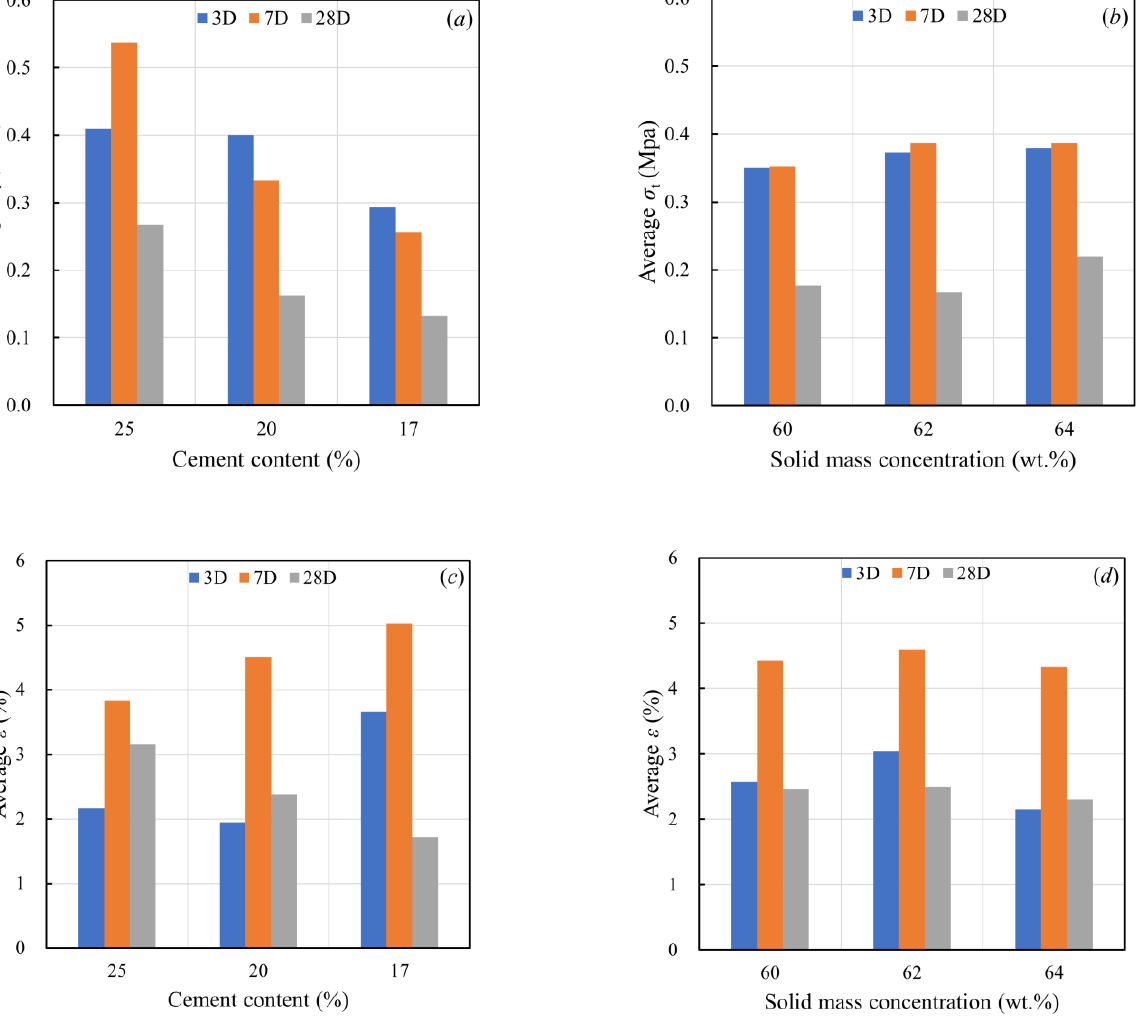
Figure 6. The influences of cement content and solid mass concentration on ITS and ε . ( a ) Average σ t at different cement contents; ( b ) average σ t at different solid mass concentration; ( c ) average ε at different cement contents; ( d ) average ε at different solid mass concentration.